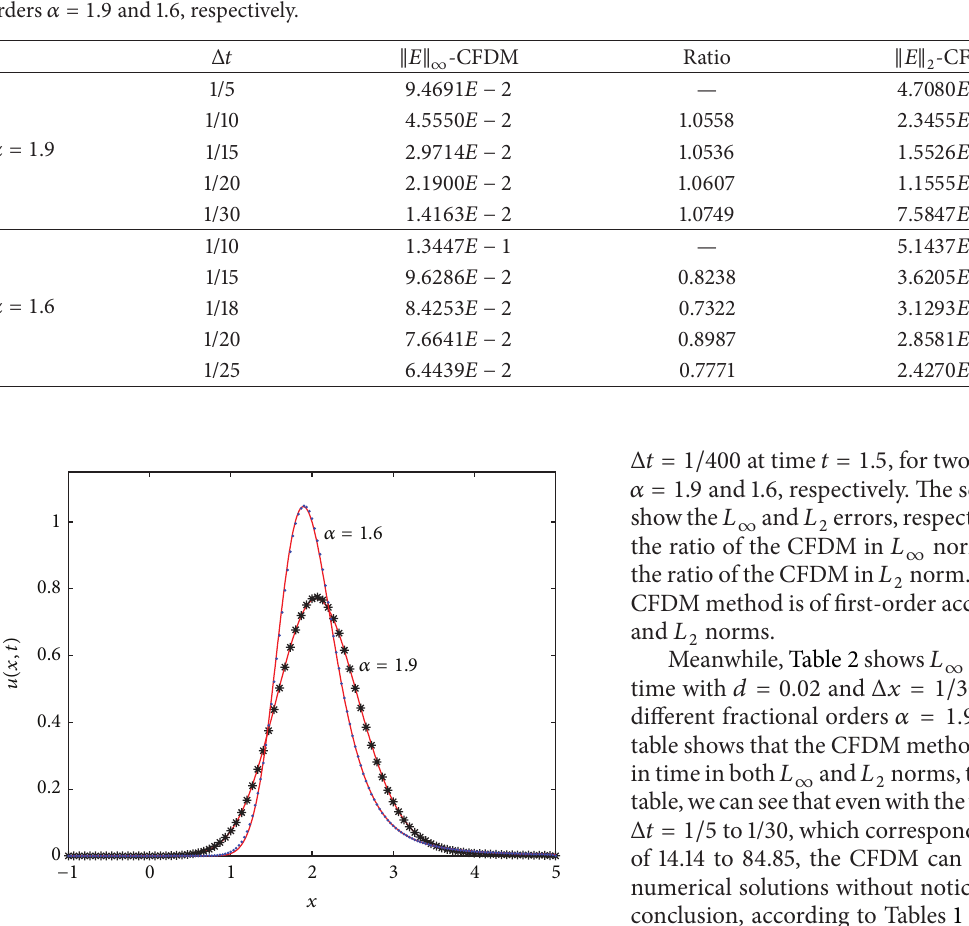
Figure 1: Exact solutions and numerical solutions obtained by the CFDM with 𝑑 = 0.1 , Δ𝑥 = 1/90 , and Δ𝑡 = 1/30 at 𝑡 = 1.5 . The solid lines correspond to the exact solutions. The starred and dotted lines correspond to numerical solutions for 𝛼 = 1.9 and 1.6,